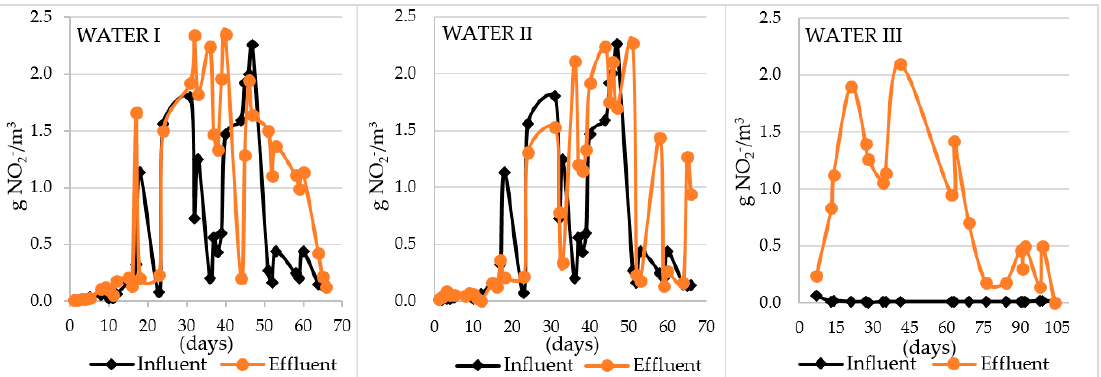
Figure 3. Change in the content of nitrite nitrogen compounds after biofiltration on the chalcedonite bed in the analyzed systems.